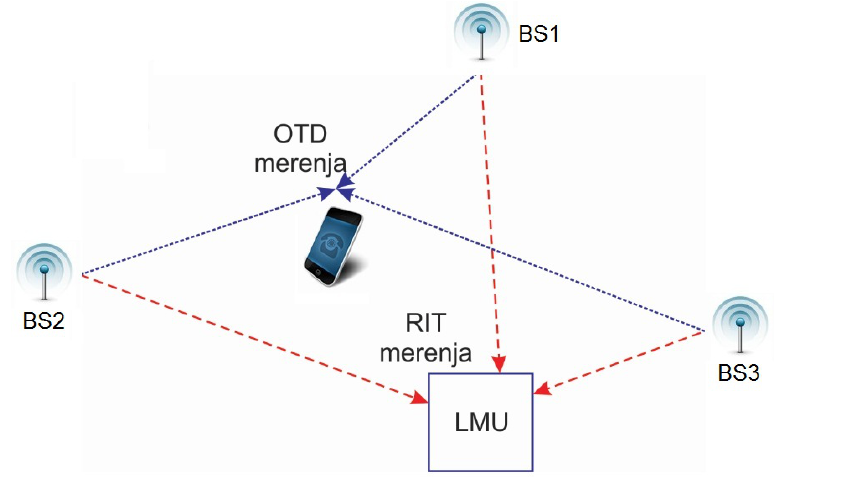
(Radio Interface Timing)